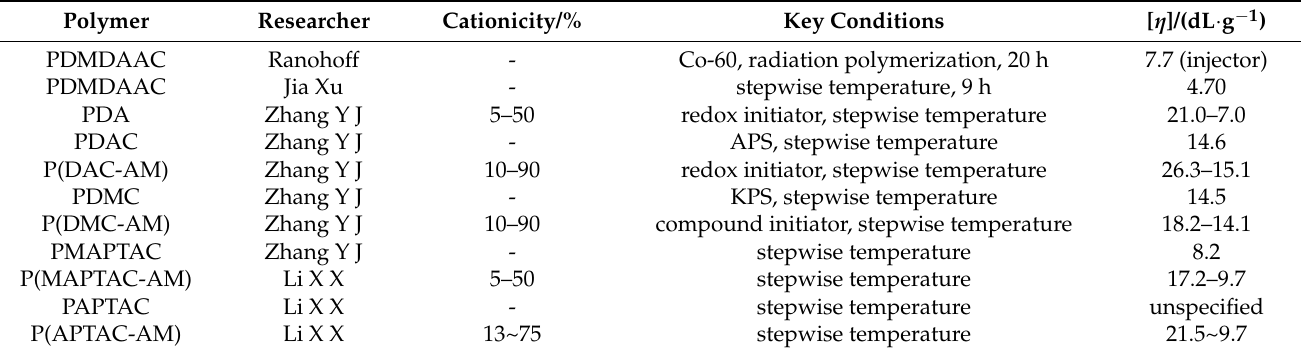
Table 1. Summarization of the highest intrinsic viscosity quaternary ammonium salt